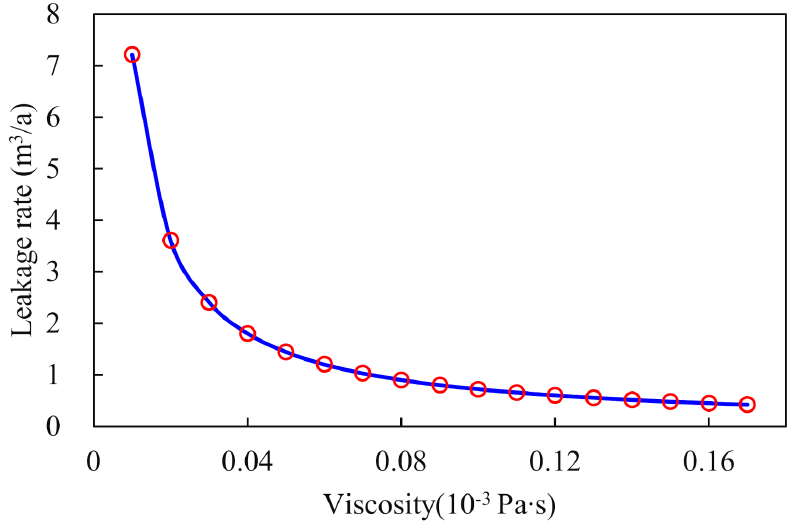
Figure 10. The effect of the viscosity of formation fluids on the leakage rate. The borehole diameter positively correlated with the leakage rate (Figure 11). An increase in the borehole diameter raised the contact area between the cement sheath and the casing, as well as the ITZ . When the diameter of the drill bit was constant, a larger diameter of the wellbore led to a greater expansion rate, which increased by 88% as the hole diameter was enlarged by 14%. The expansion rate of the borehole should be controlled during the